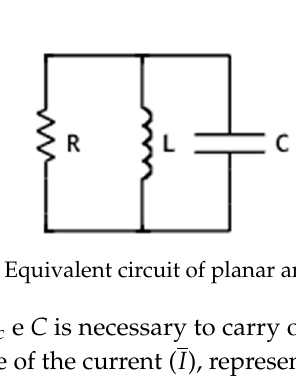
Figure 6. Equivalent circuit of planar antenna [16].